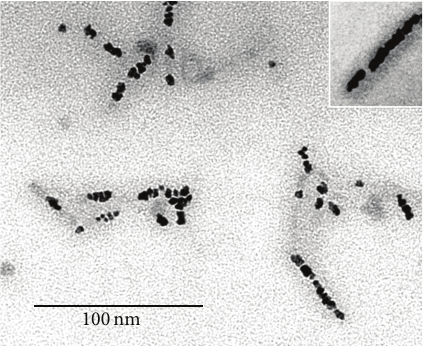
Figure 6: Nanoparticles of platinum fill the inner canal of the TMV VLP. TEM images of Pt nanoparticles in the inner canal of the virus- like rods produced from the coat protein of TMV. Incubation of VLP with (dien)platinum followed by electroless deposition of Pt atoms took place under the same conditions as with TMV. Inset in the upper corner indicates clearly the coat protein tube around the Pt nanoparticles. No contrasting of specimen was done.